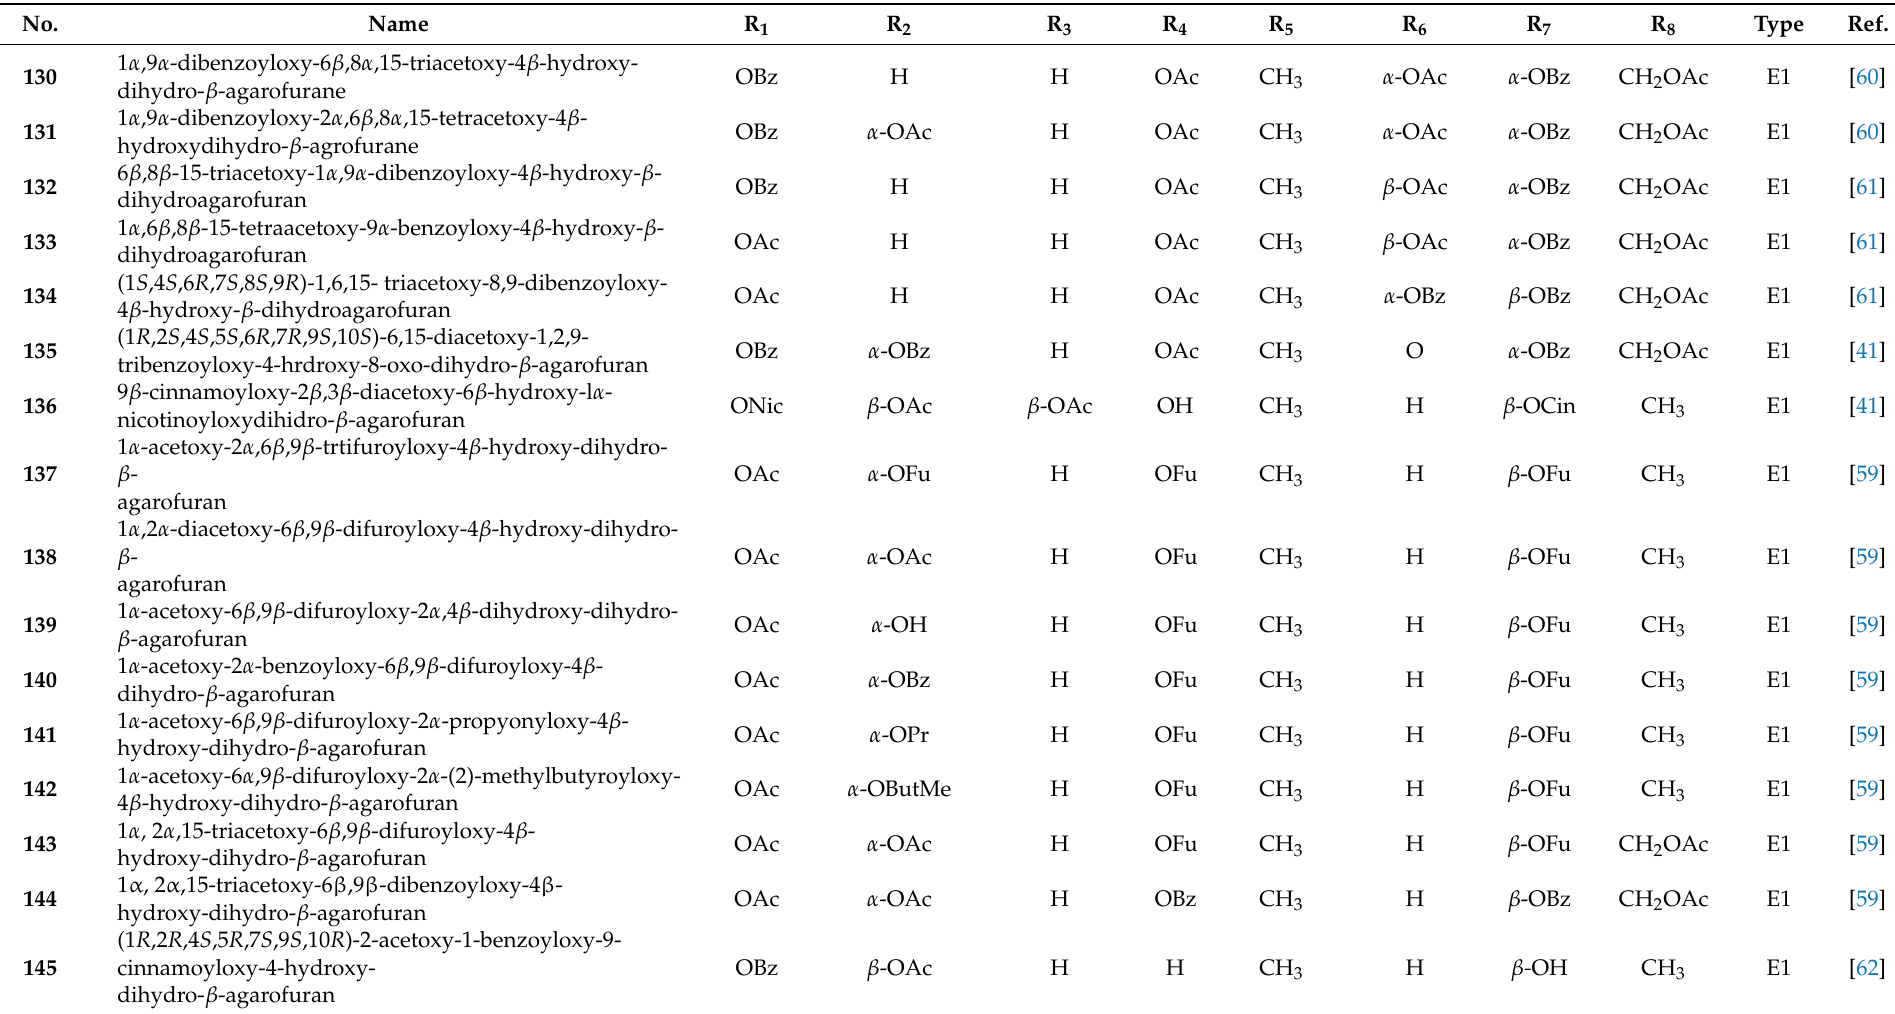
Table 5. The sesqiterpenoids isolated from Maytenus